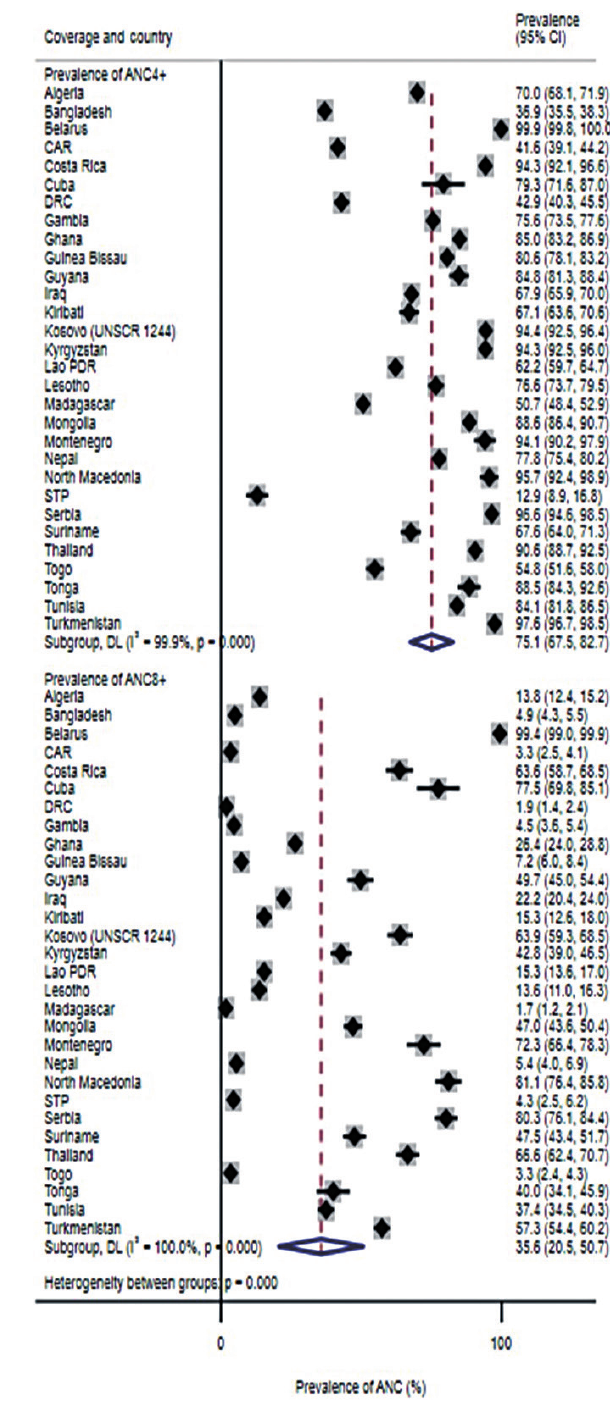
Figure 1. Coverage of 4 or more antenatal care contacts (ANC4+) and 8 or more antenatal care contacts (ANC8+) by country and overall. CI, confidence interval; CAR, Central African Republic; DRC, Democratic Republic of the Congo; Lao PDR, Lao People’s Demo- cratic Republic; STP, São Tomé and